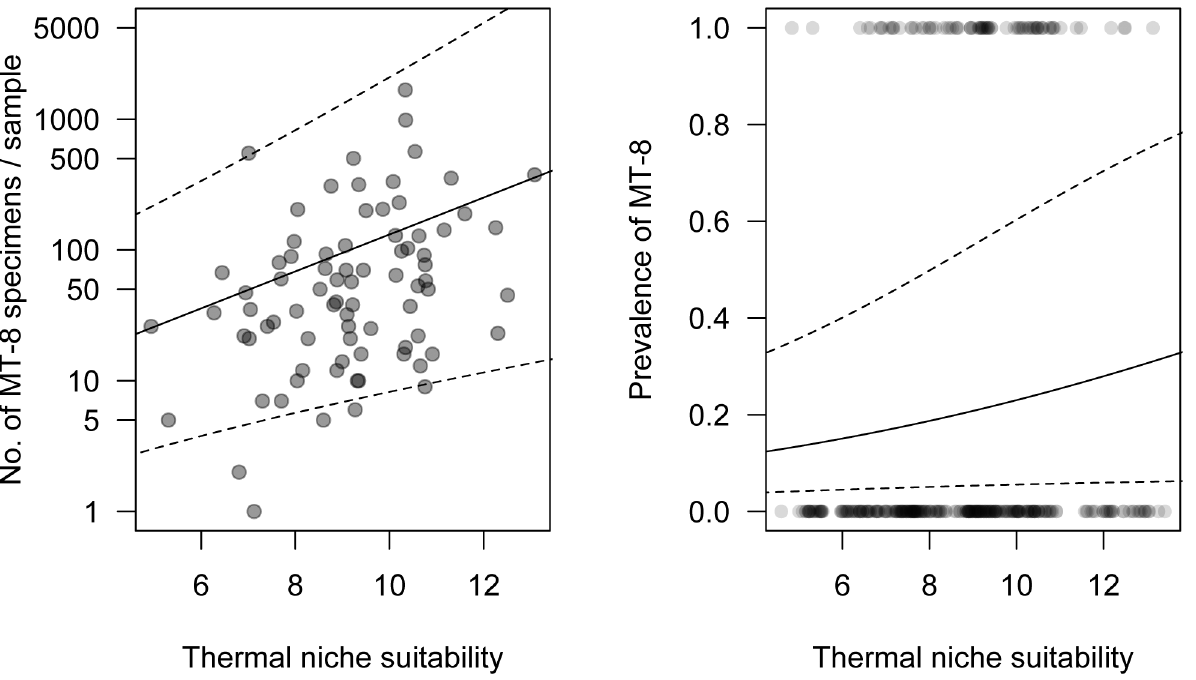
Fig 7. The hurdle model relating thermal niche suitability (TNS) to abundance (A) and prevalence (B) of Aceria tosichella lineage MT-8. Solid lines are predictions from the model and dashed lines represent standard error bands. Both abundance and prevalence of MT-8 were significantly dependent on